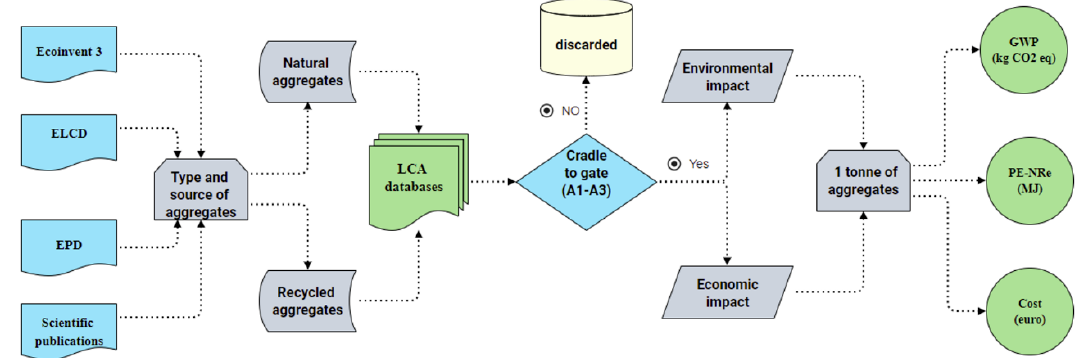
Figure 1. Flowchart of the data collection process.